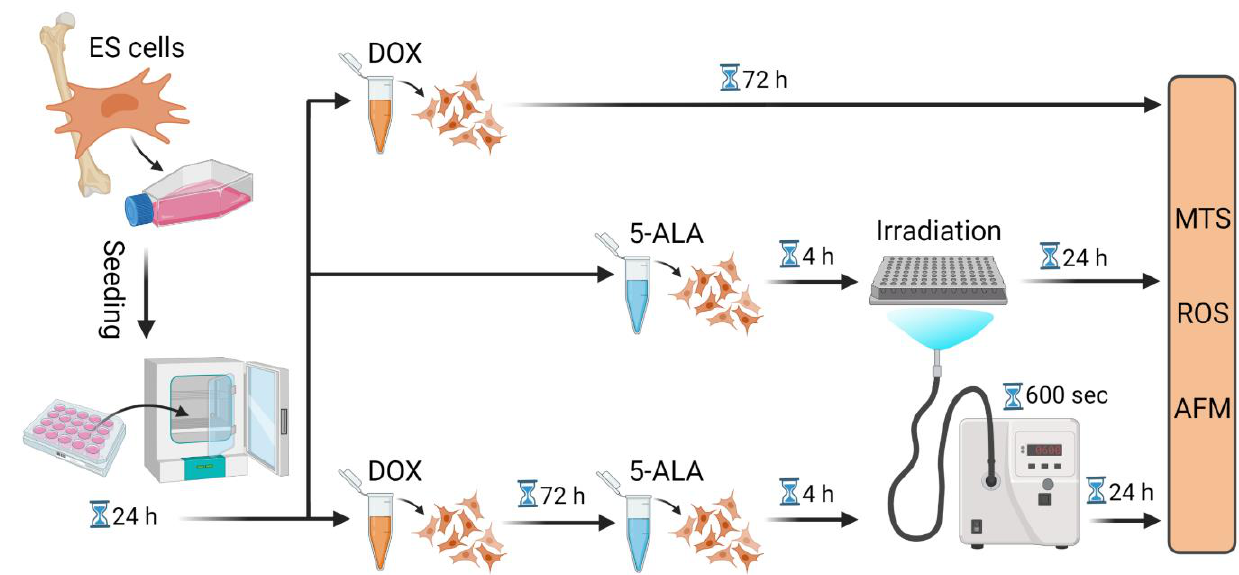
Figure 1. Flow chart of the experimental procedure. Summary of the experimental steps in chrono- logical order, starting from cell seeding to treatment with DOX and/or 5-ALA followed by irradi- ation. Further measurements were then conducted. Created with BioRender.com. Abbreviations: